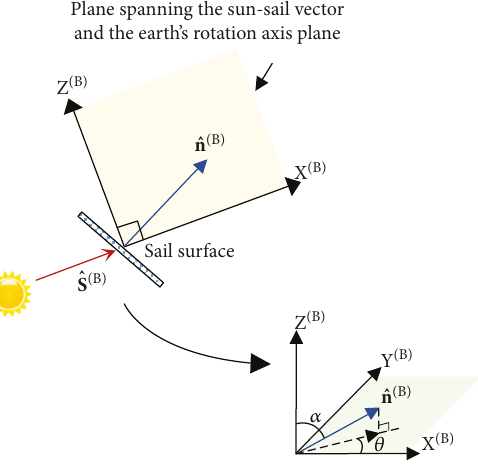
Figure 2: Frame (B) with sail normal vector ̂ n , pitch angle α , and yaw angle θ .